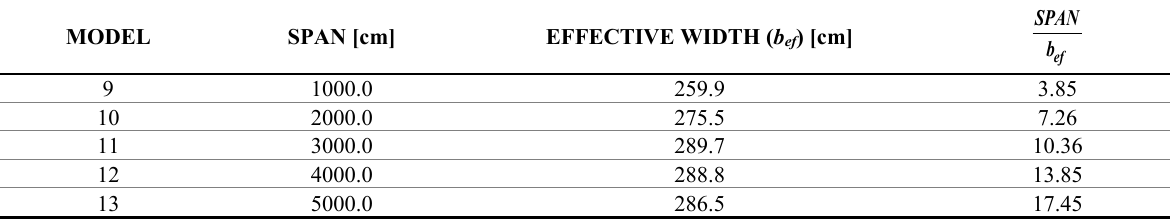
Table 5. Relationship between the effective numerical width and the longitudinal span length for the simple box con figuration.